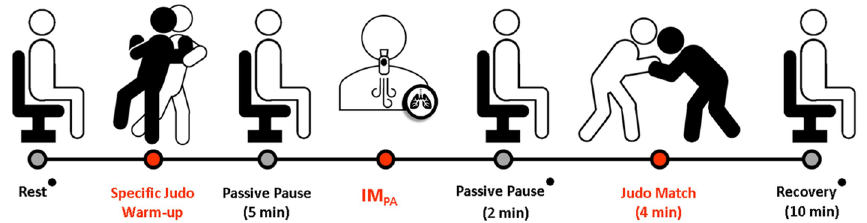
Figure 1. Timeline for the execution of the assessment sessions, considering the Inspiratory Muscles Pre- Activation (IM PA ) before a judo match and passive recovery. (filled circle) Physiological parameters collected at rest, pre and post combat, and recovery at each 2 min until 10